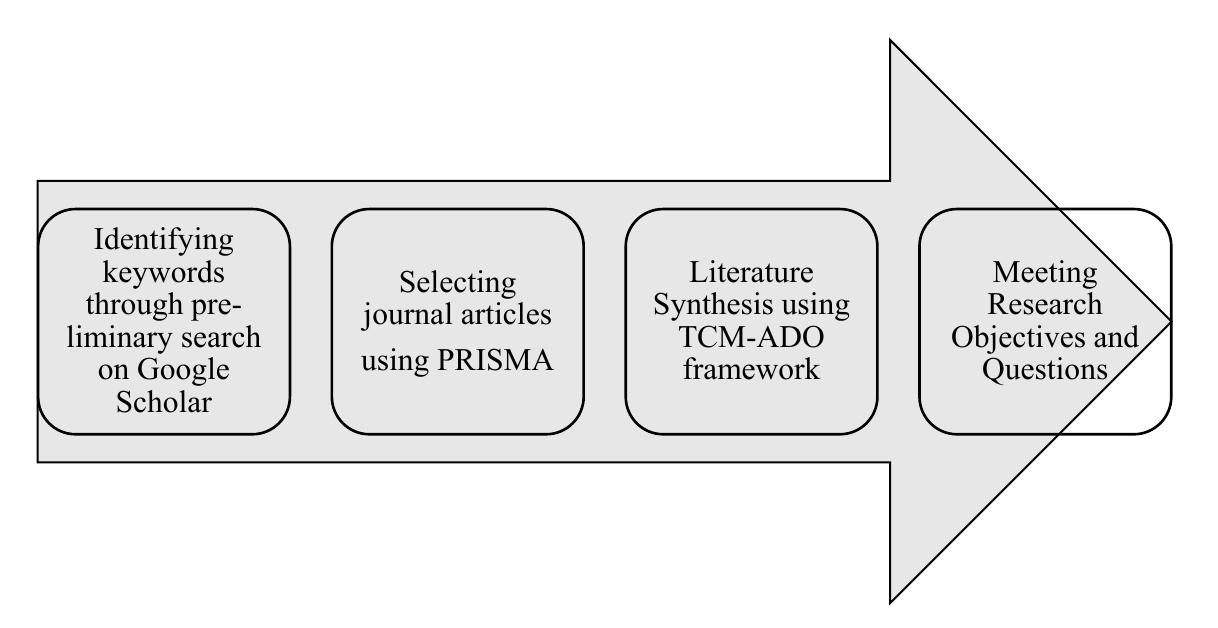
Figure 3. Review Process.